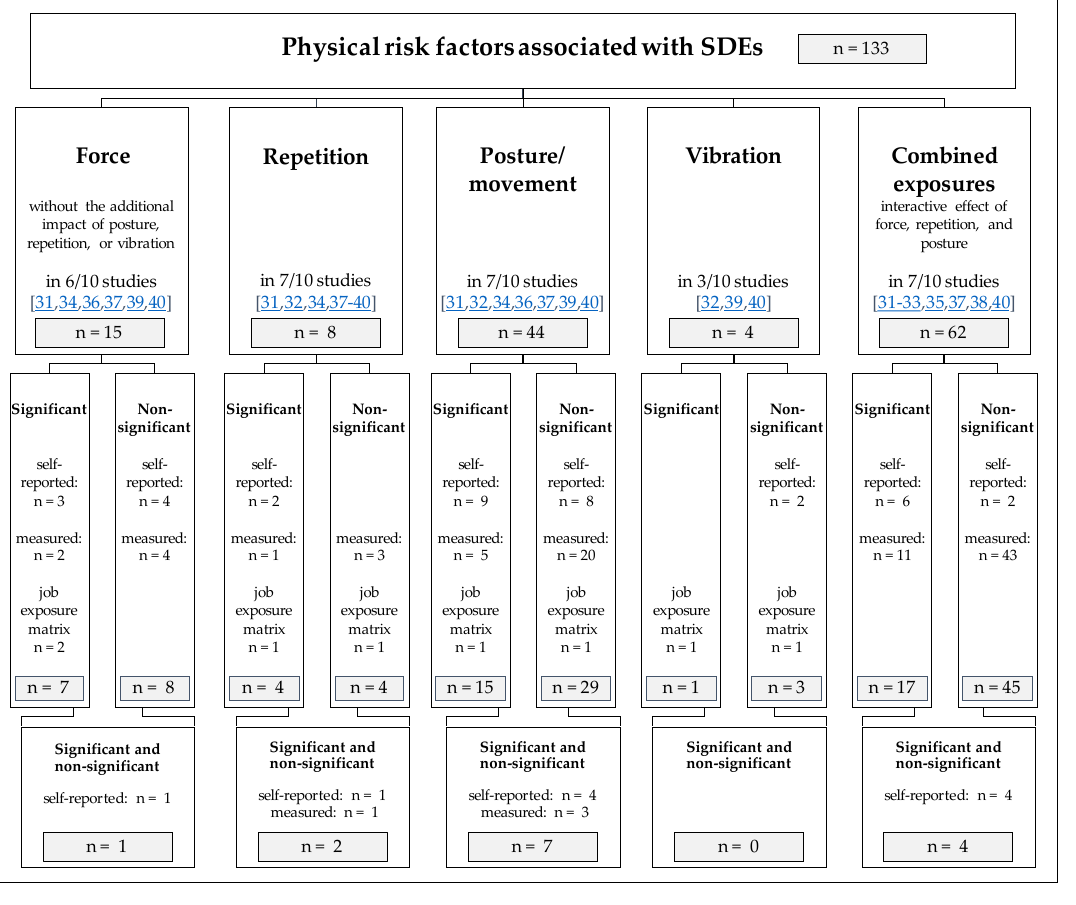
Figure 2. Distribution of physical risk factors associated with SDEs: The graph shows the distribution of all risk-factor specifications among the 5 main exposure groups with numbers of different exposure determinations and numbers of referring studies.